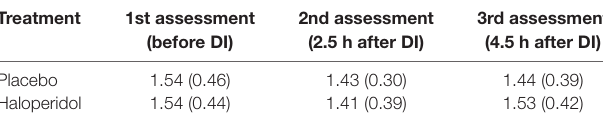
TABLE 1 | Likert ratings for potential side effects (1 = no side effects; 7 = extreme side effects) before, during and after the fMRI experiment in the placebo and haloperidol condition ( n = 20).